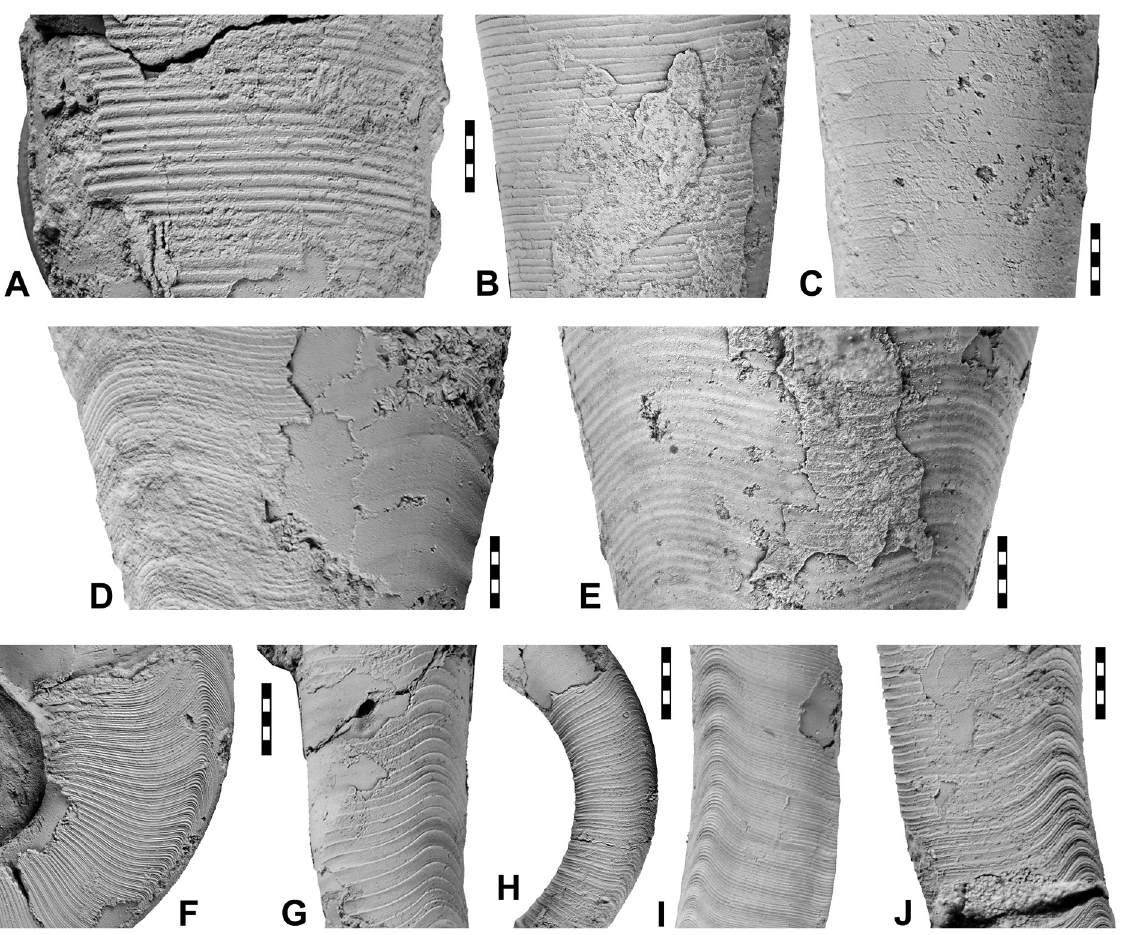
Fig. 8. Ornament details of lituitid specimens. A . Coarse lirae, symmetric crests; Rhynchorthoceras angelini (Boll, 1857), specimen MB.C.30495.1. B . Coarse lirae, asymmetric crests; R. angelini (Boll, 1857), specimen MB.C.11716. C . Faint, widestanding striae; R. rugium sp. nov., holotype